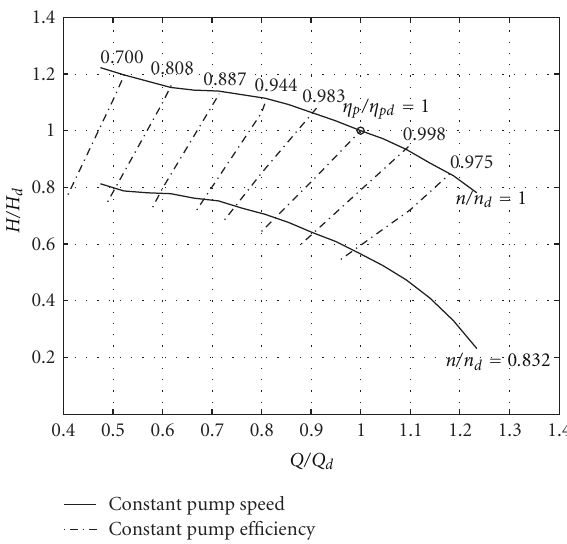
Figure 5: Comparison between performance maps of two axial- flow pumps.